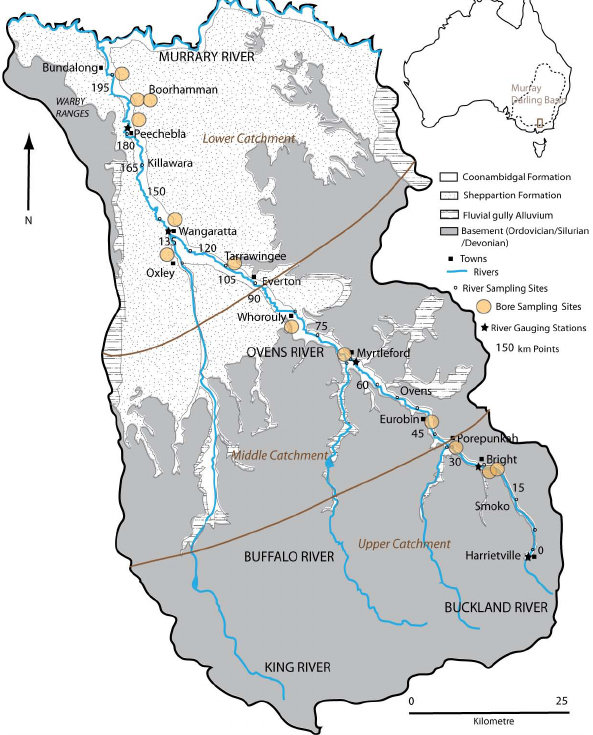
Fig. 1. Map of the Ovens River Catchment showing surface geology, sampling sites and gauging stations. Data from van den Berg and Morand (1997); Victorian Water Resource Data Warehouse